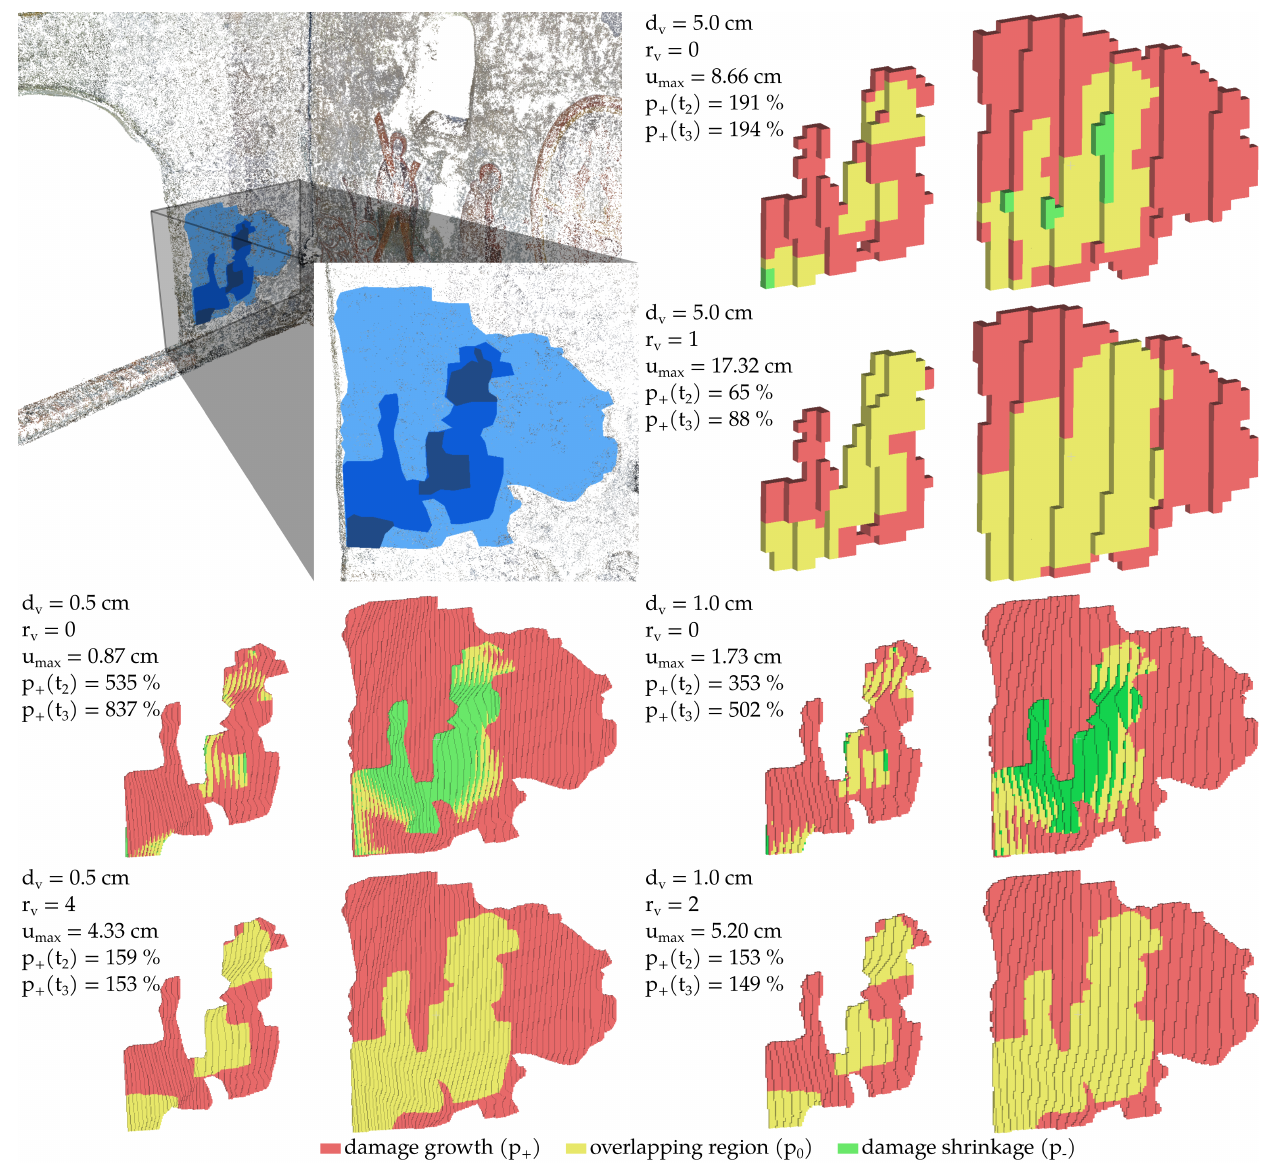
Figure 12. Results for a missing plaster annotation applying the voxel-based assignment and compar- ison of (left of each pair) t 1 and t 2 and (right of each pair) t 2 and t 3 showing the effects of a too small definition of r v and the percentage growth p + computed from different d v .